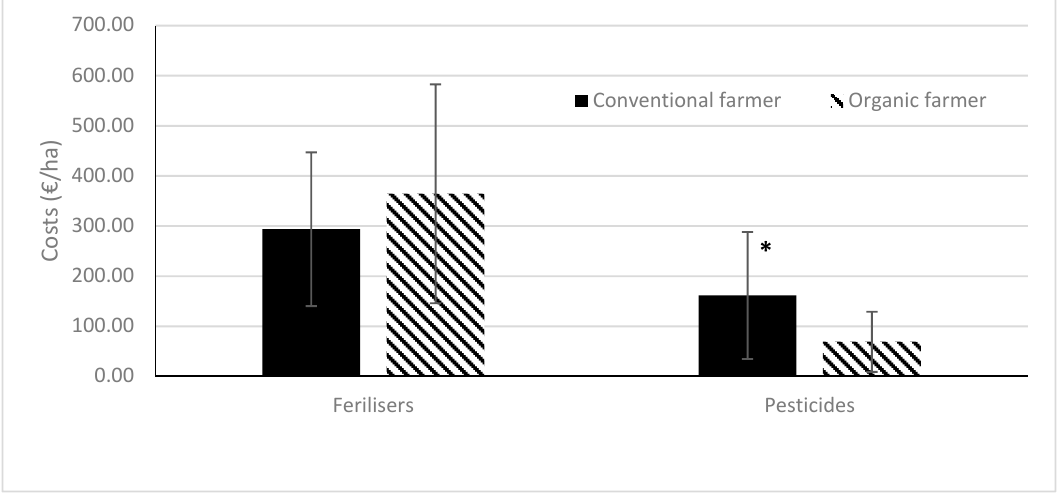
Figure 8. Annual income, costs and profits from olive oil production among organic ( n = 16) and conventional ( n = 23) olive farmers in Messenia, Greece. The error bars indicate the standard deviations. The asterisks (*) mark statistically significant differences (<0.05) between the two groups of farmers.